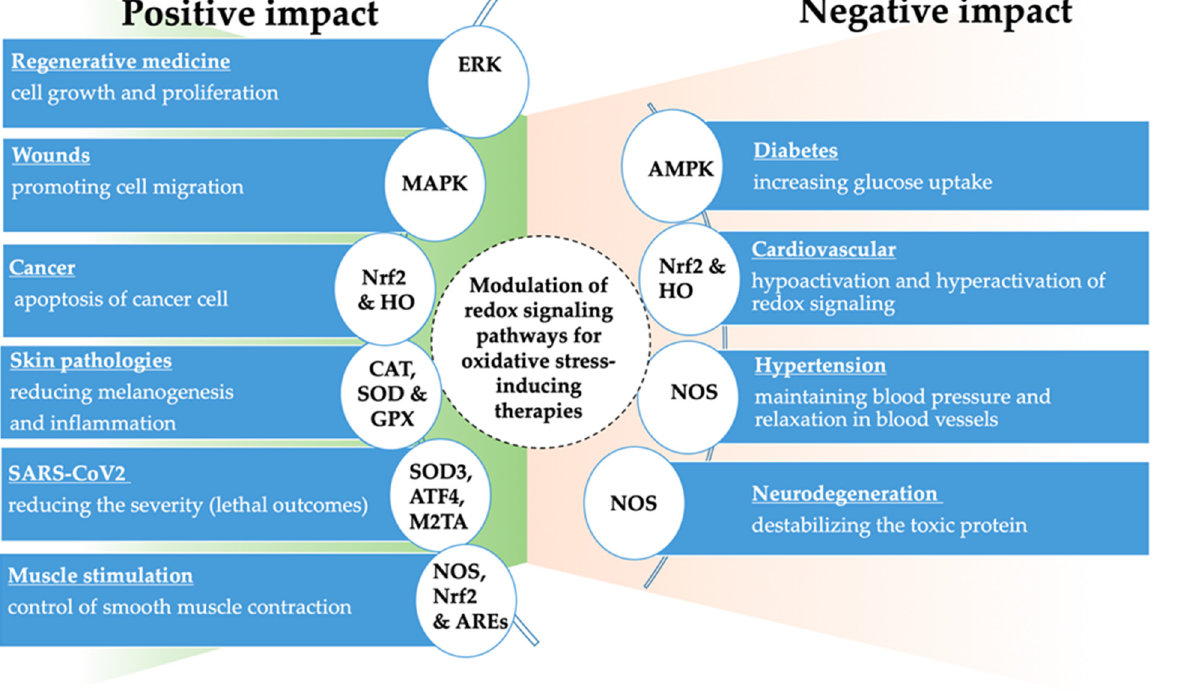
Figure 2. Medical conditions and summary of the known effects of oxidative stress-inducing therapies.